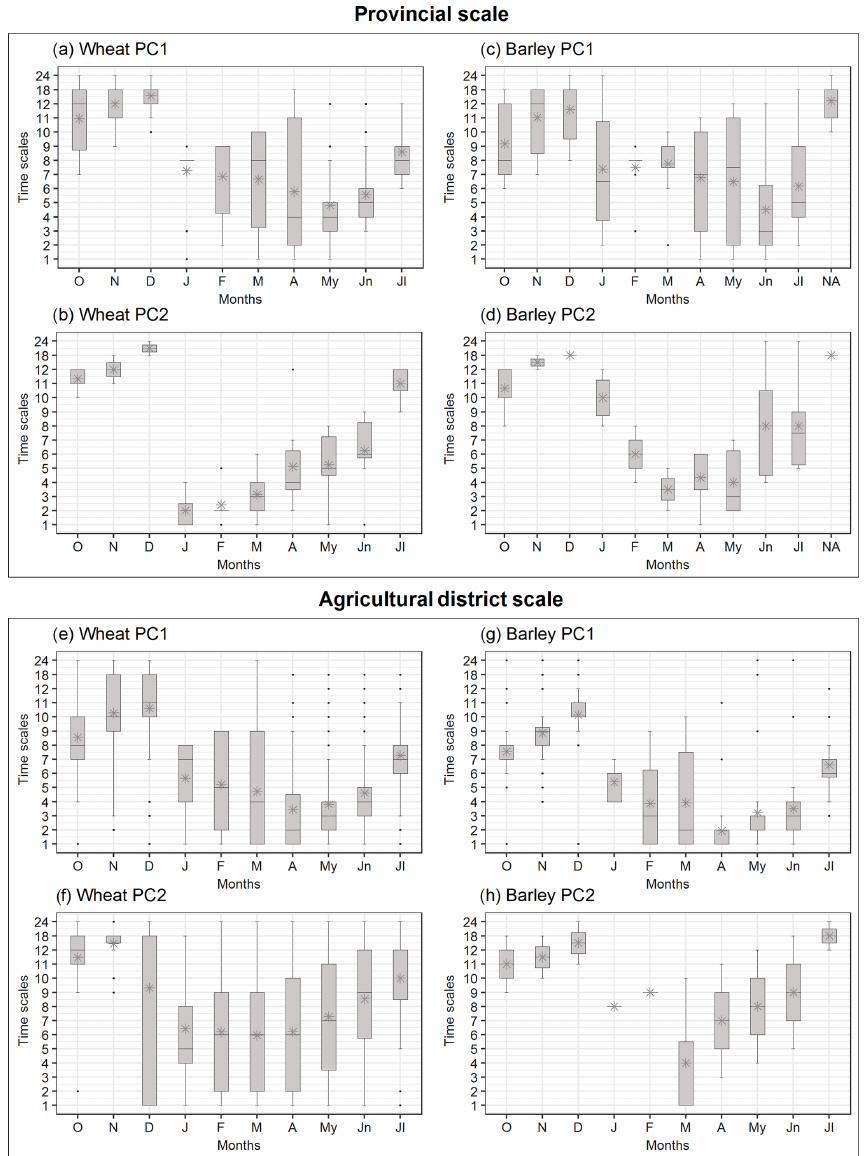
Figure 9. Box plots showing the timescale at which significant monthly correlations were found in the provinces (a–d) and agricultural districts (e–h) for wheat and barley for each of the components defined in the